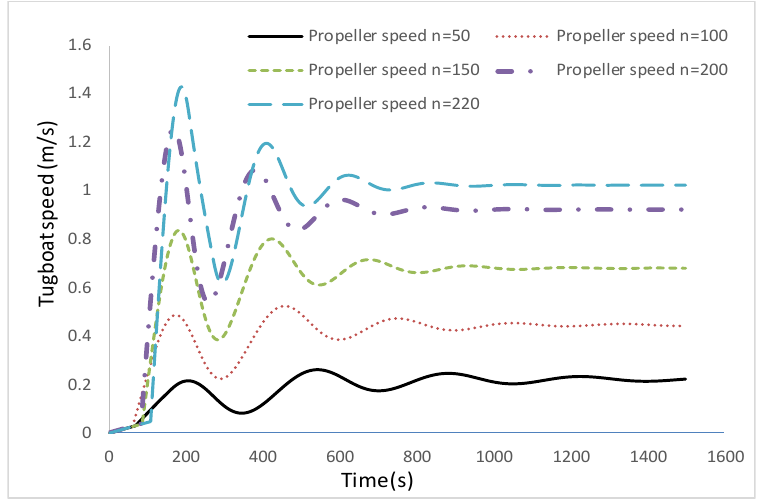
Figure 7. Speed variation curve of tug at different speeds.